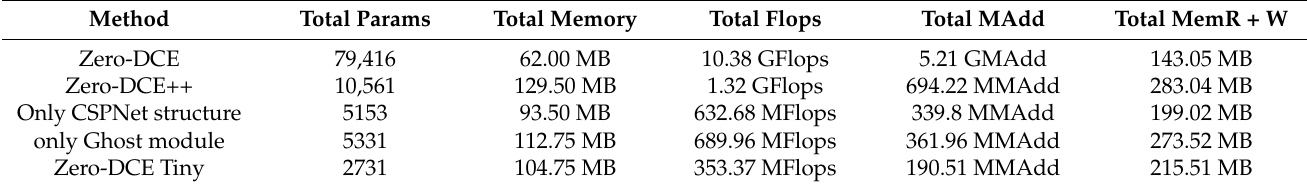
Table 1. Parameter comparison of the backbone network; the parameter is computed for an image of size 256 × 256 ×